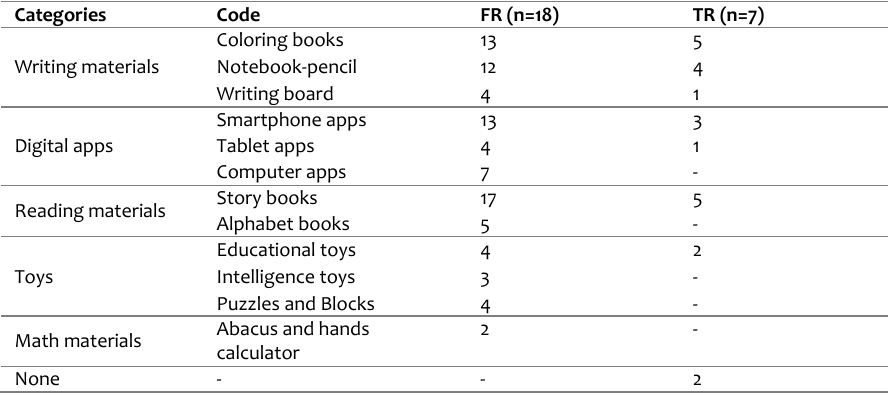
Table 4. Materials provided by mothers to support the literacy skills of their children